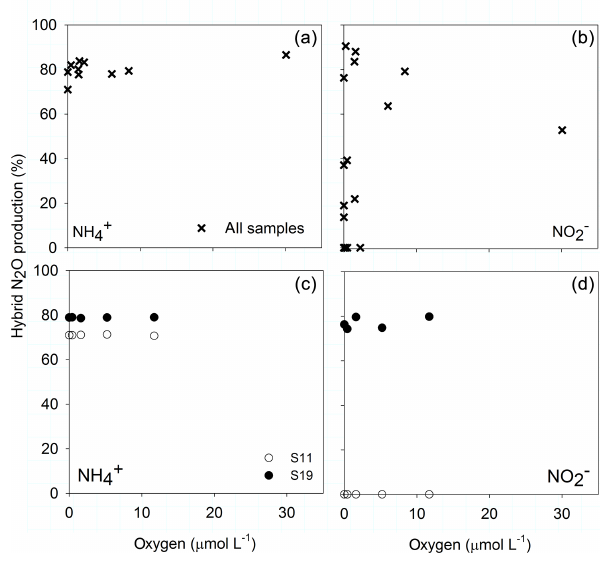
Figure 5. O 2 dependency of hybrid N 2 O formation from NH + c) and NO − (b, d) along the natural O 2 gradient (a, b) and for the 2 O 2 manipulations (c, d) from sample S11 (0µmolL − 1 O 2 , 145m) and S19 (894, 0µmolL − 1 ,